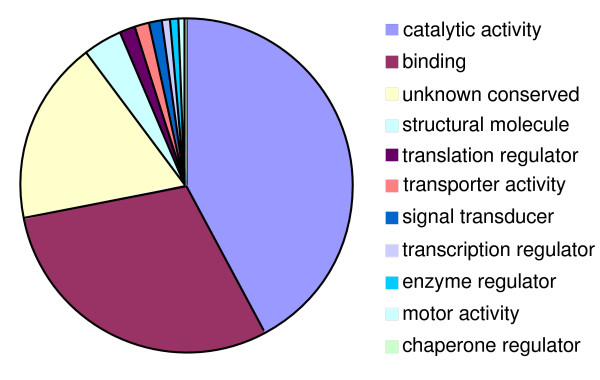
Functional categories of expressed genes covered by all EST. A total of 3862 genes matched by EST were sorted according to GO molecular functions with P values < 0.0001 on sequence matches. The majority of the genes encode housekeeping proteins involved in DNA/RNA and protein binding, enzyme catalytic activities, transcription, translation, signal transduction, and transport activities.